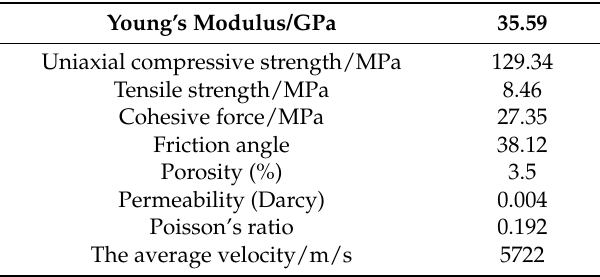
Table 1. Material parameters of carbonate used in triaxial fracturing